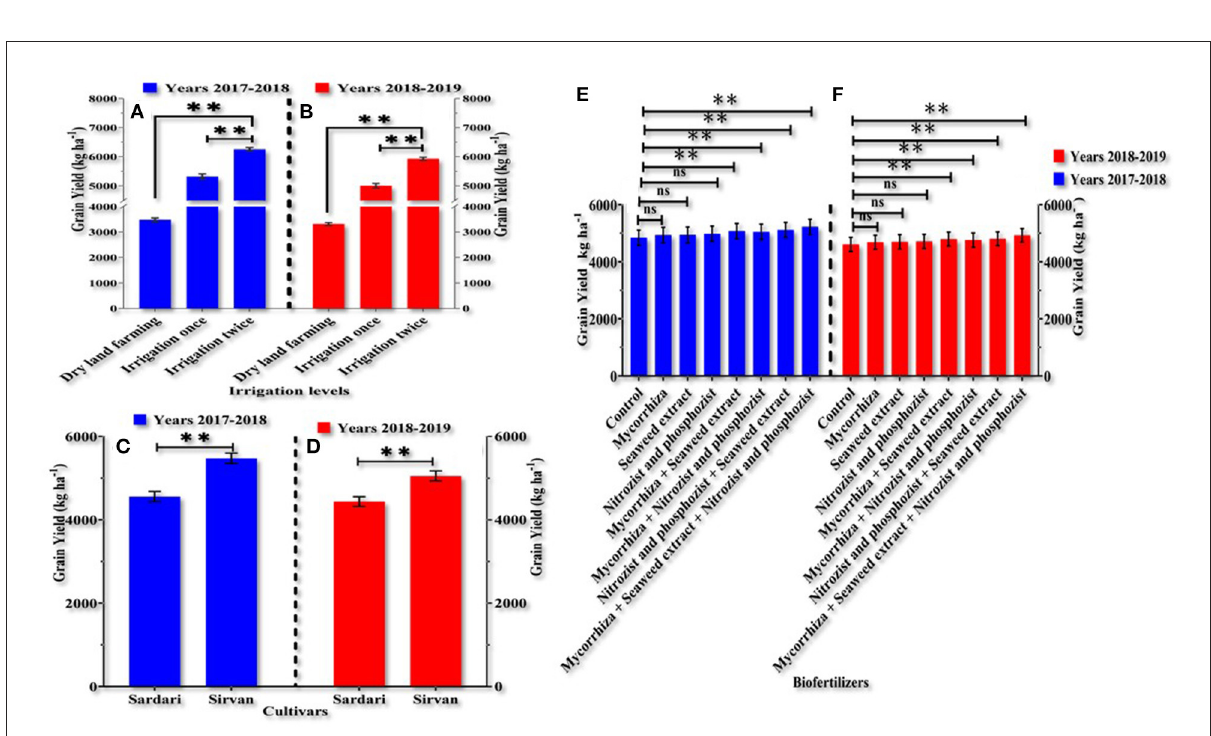
FIGURE6 Mean comparisons main effects of irrigation levels (A,B) , cultivars (C,D) and bio-fertilizers (E,F) on grain yield in wheat plant in years 2017–2018 and 2018–2019. At p > 0.05, ns, not significant; and **0.001 < p ≤